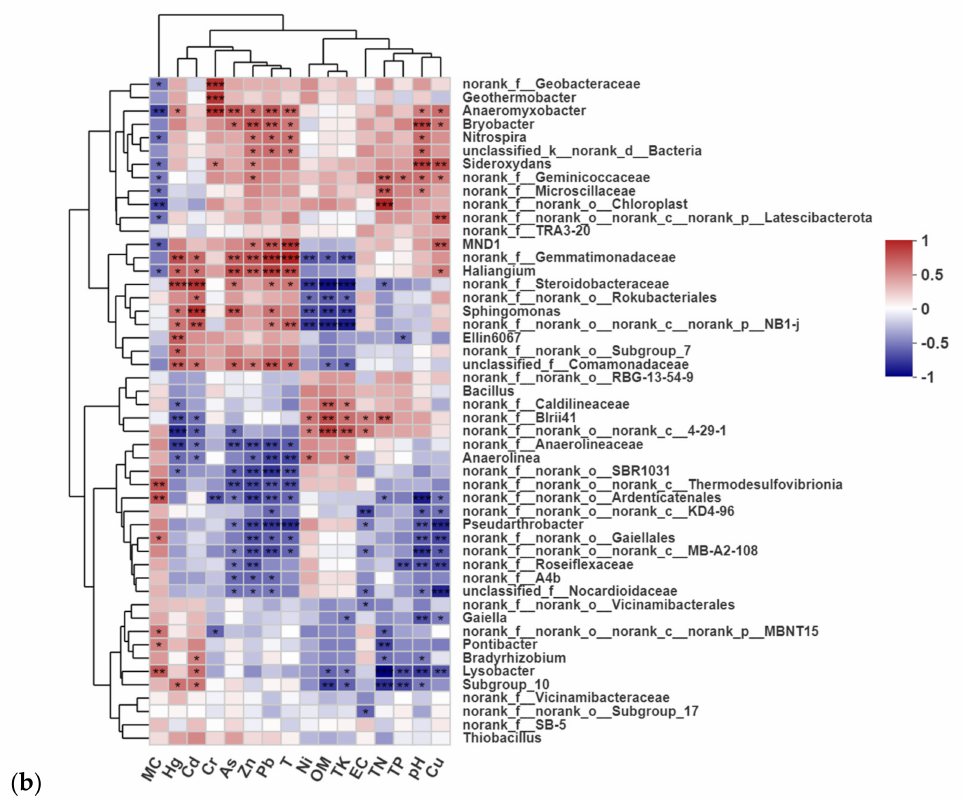
Figure 7. The Spearman correlation analysis of environmental factors and top genus of the PM ( a ) and OF ( b ) tests. (* p < 0.05; ** p < 0.01; *** p <